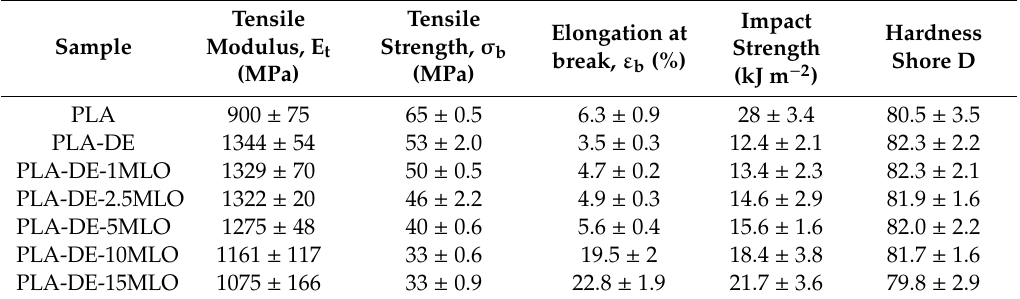
Table 6. Summary of mechanical properties of PLA / DE composites with varying MLO loading, obtained from tensile, impact and hardness